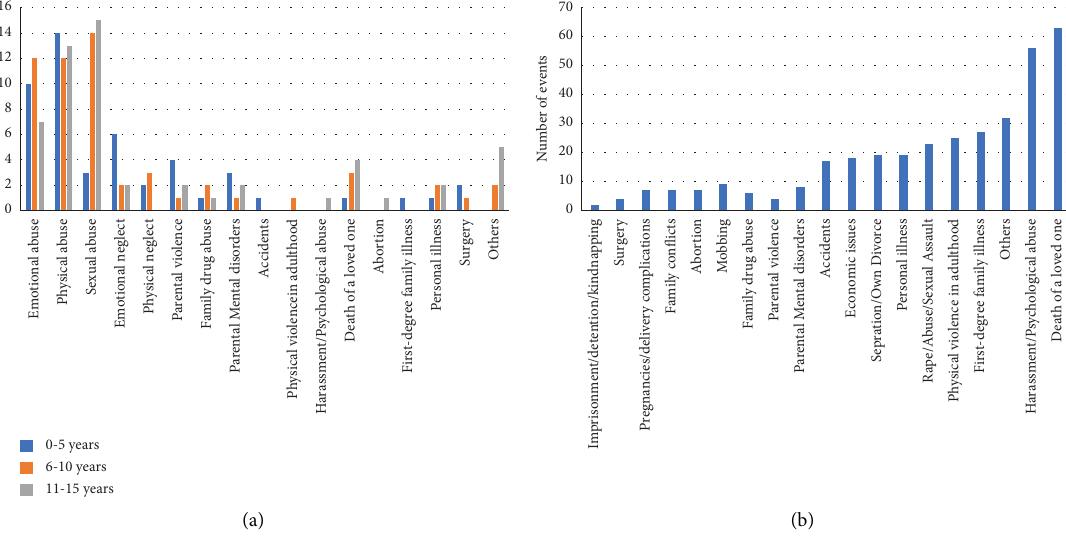
Figure 2: Number and typology of traumatic events (a) between 0 and 15 years ( n � 77), and (b) between 16 and 70 years ( n �